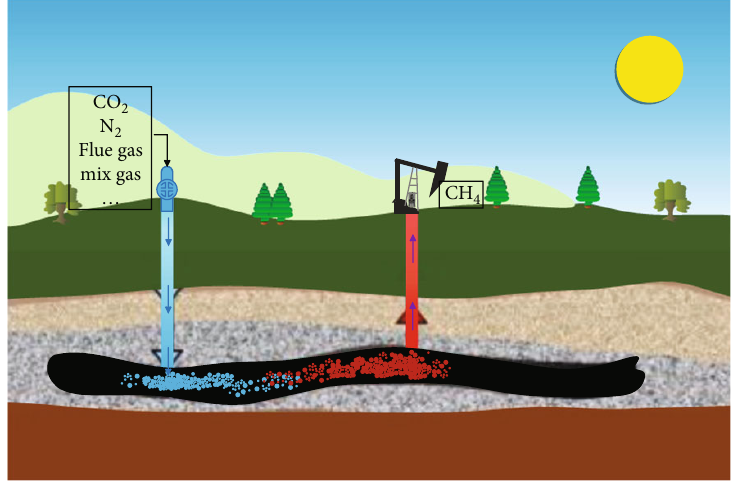
Figure 18: Illustration of the CO -ECBM technique to stimulate coal seam methane gas production 2